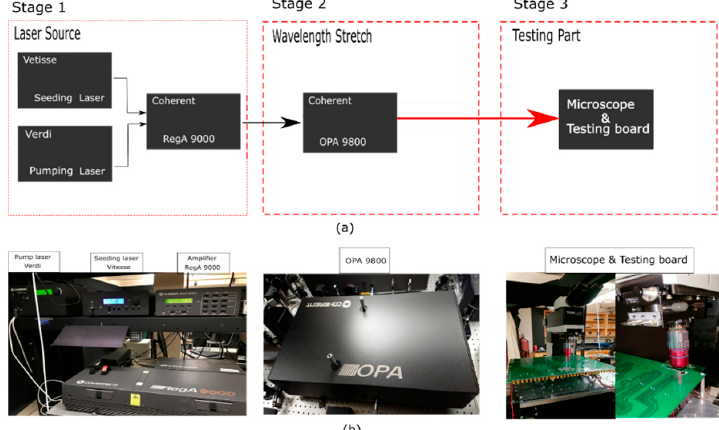
Figure 1. ( a ) Schematic of the two photon absorption (TPA) laser testing system. ( b ) actual profile of the single event effect (SEE) testing system.